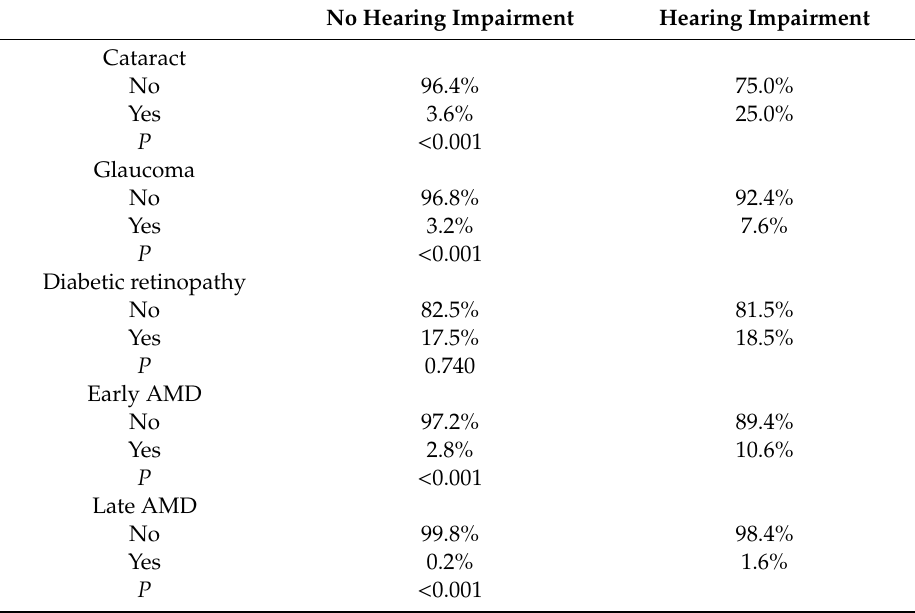
Table 3. Weighted prevalences of eye diseases in those without and with hearing impairment.